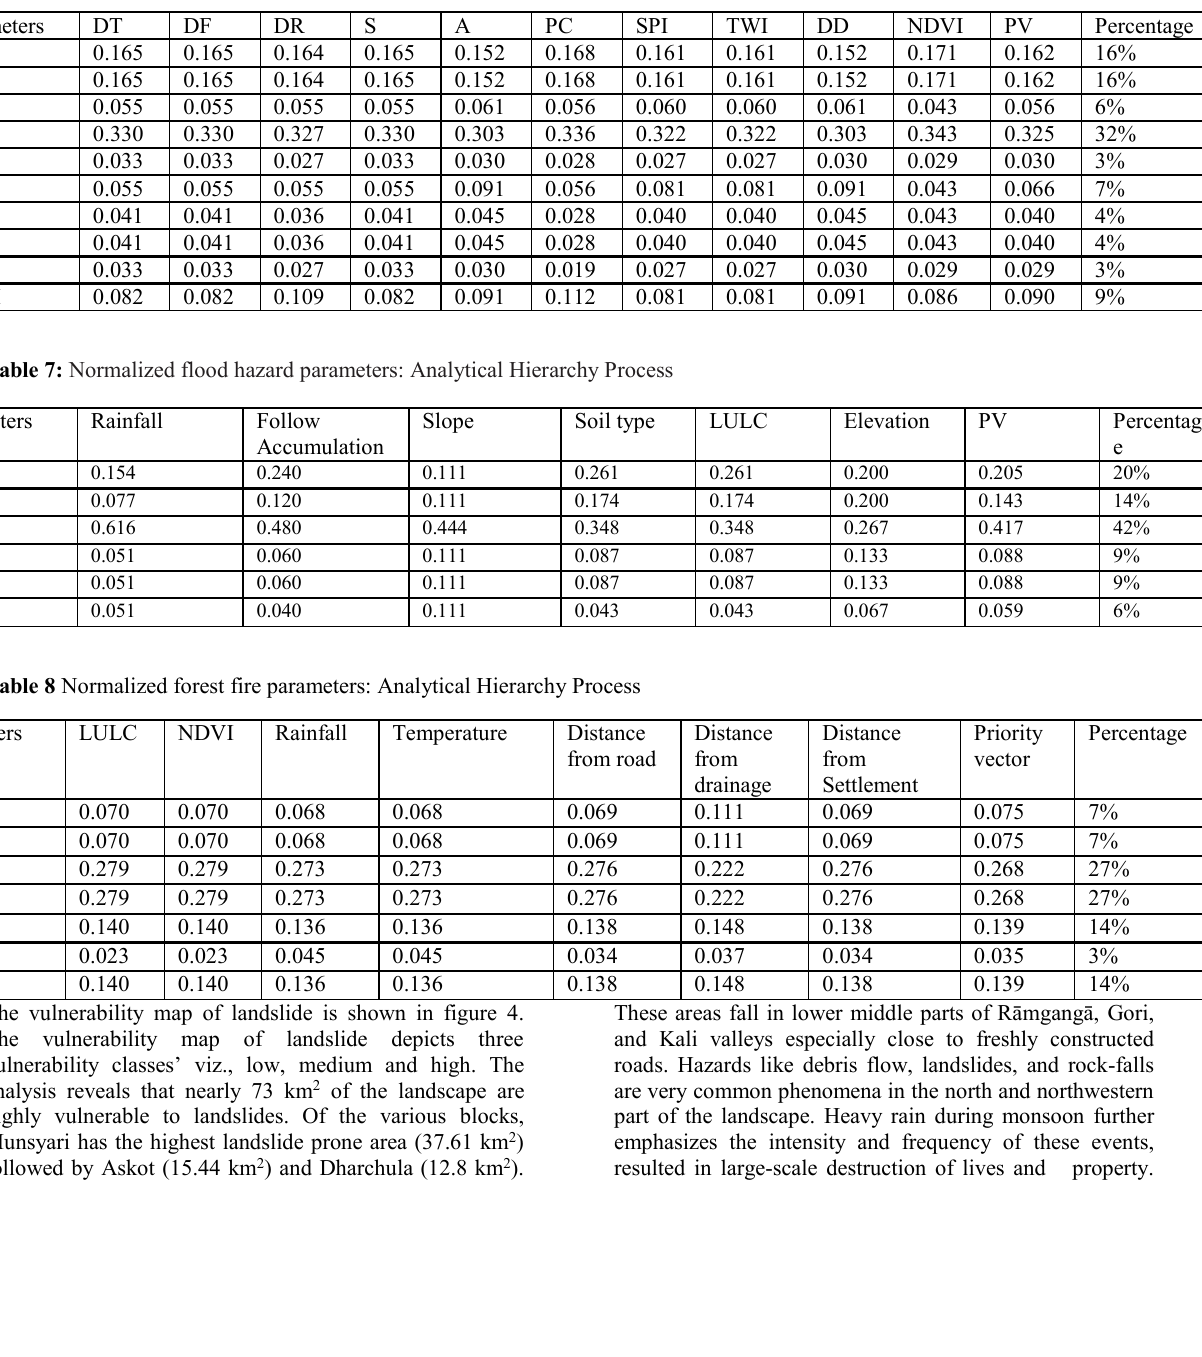
Table 6 Normalized Landslide Hazard Parameters: Analytical Hierarchy Process